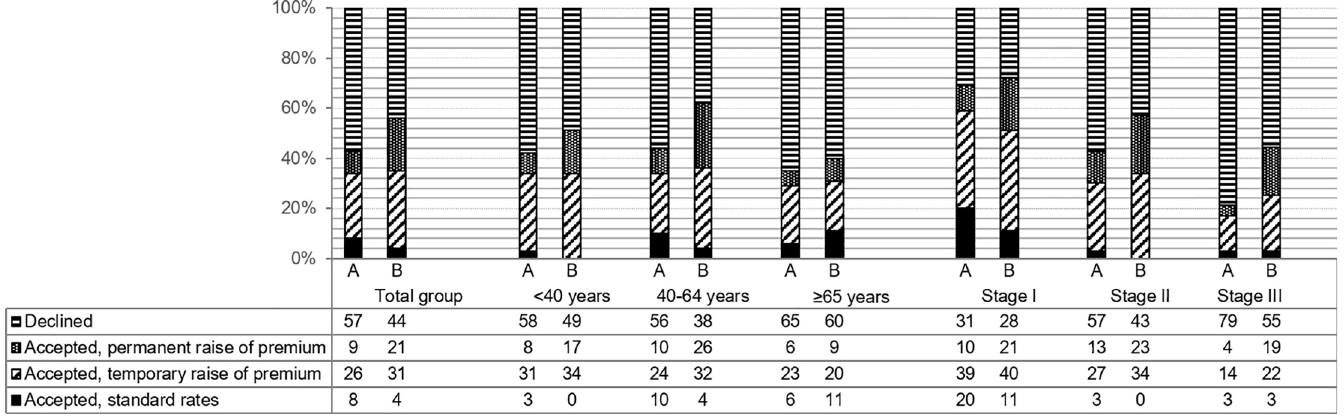
Fig 1. Comparison of insurability of (ex-)breast cancer patients between currently used guidelines (A) and the newly-developed model (B).